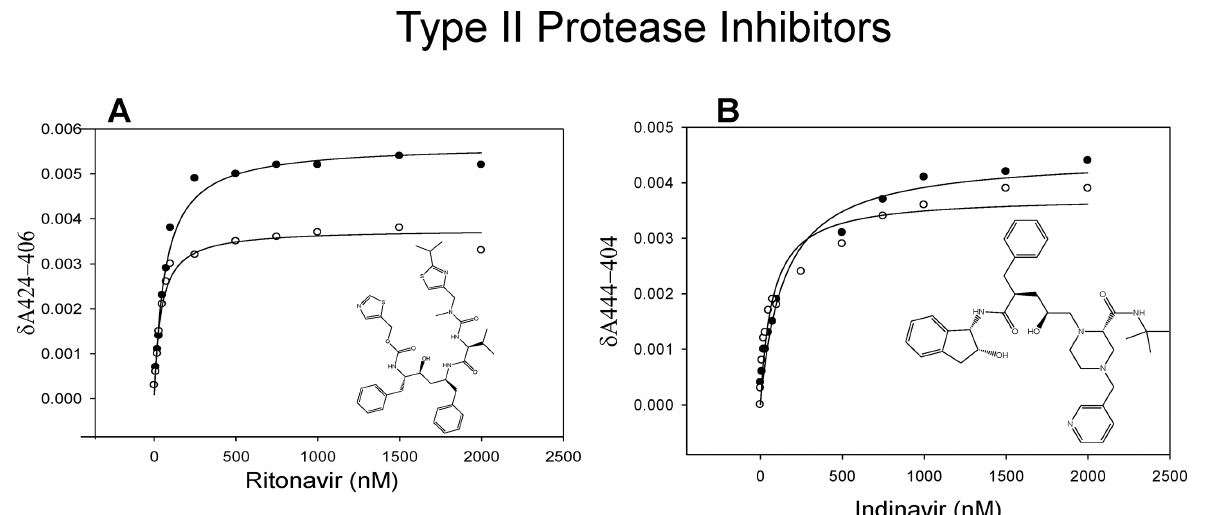
Fig 6. Spectral binding of type II PIs with CYP3A4 in the absence (filled circles) and presence (open circles) of methamphetamine. (A, B) The spectral binding was performed at varying concentrations of ritonavir and indinavir. The K D and δ A max for each PI with and without methamphetamine are presented in Table 2. One way ANOVA with Dunnet ’ s post-hoc test was employed to calculate the statistical significance. A p-value < 0.05 is indicated by * and < 0.1 is indicated by #.